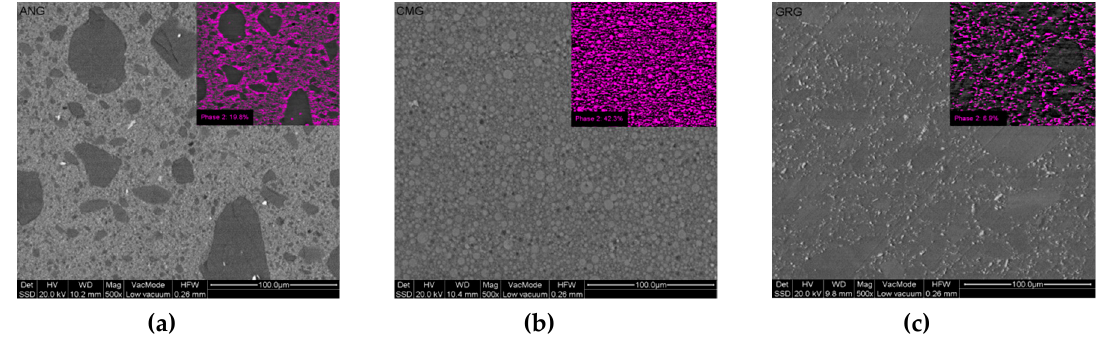
Figure 2. Atomic number contrast backscattered electron images of polished specimens of ANG ( a ), CMG ( b ) and GMG ( c ). The inserts demonstrate the area percentage of the colored phase (500×, bar = 100 μ m).